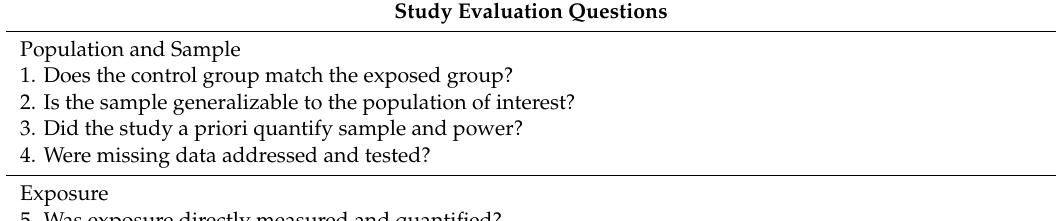
Table 1. Key study evaluation questions to determine the level of certainty ratings for health outcomes.